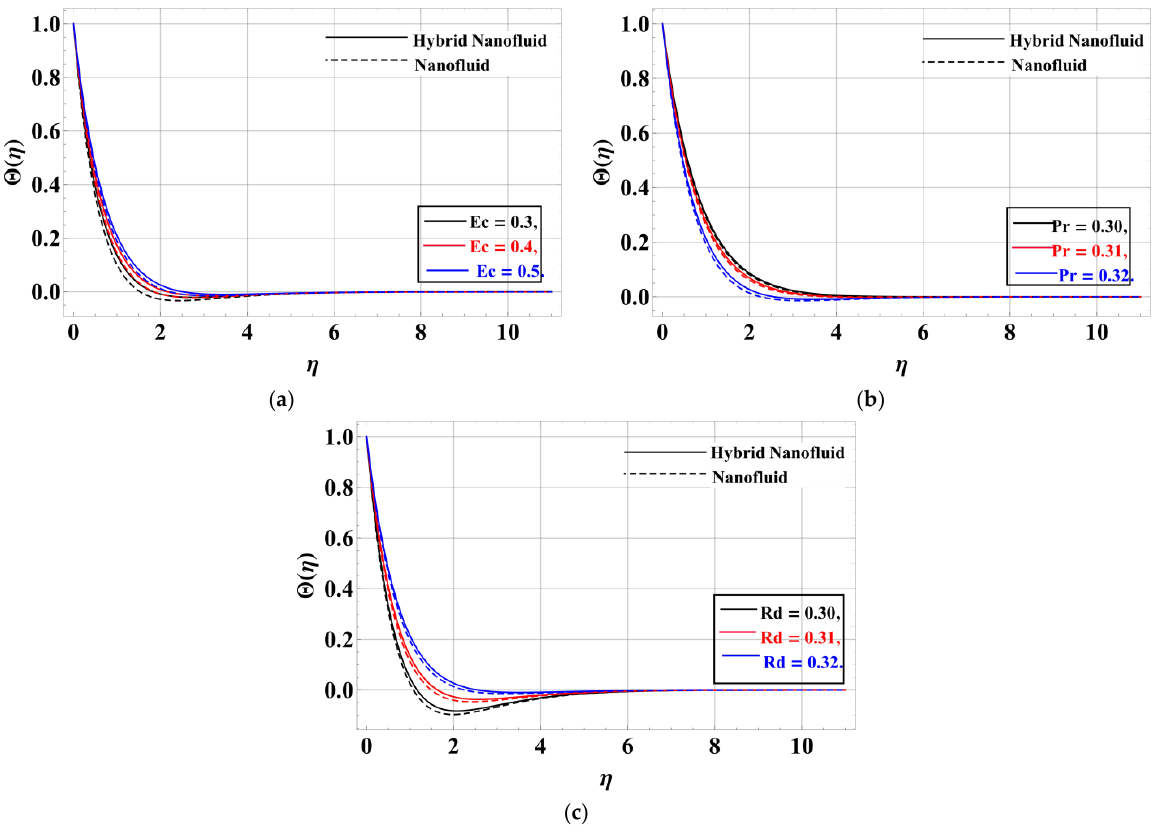
Figure 8. Variations in Θ ( η ) against Ec ,Pr & Rd . ( a ) Variations in Θ ( η ) against Ec ( b ) Variations in Θ ( η ) against Pr ( c ) Variations in Θ ( η ) against Rd .